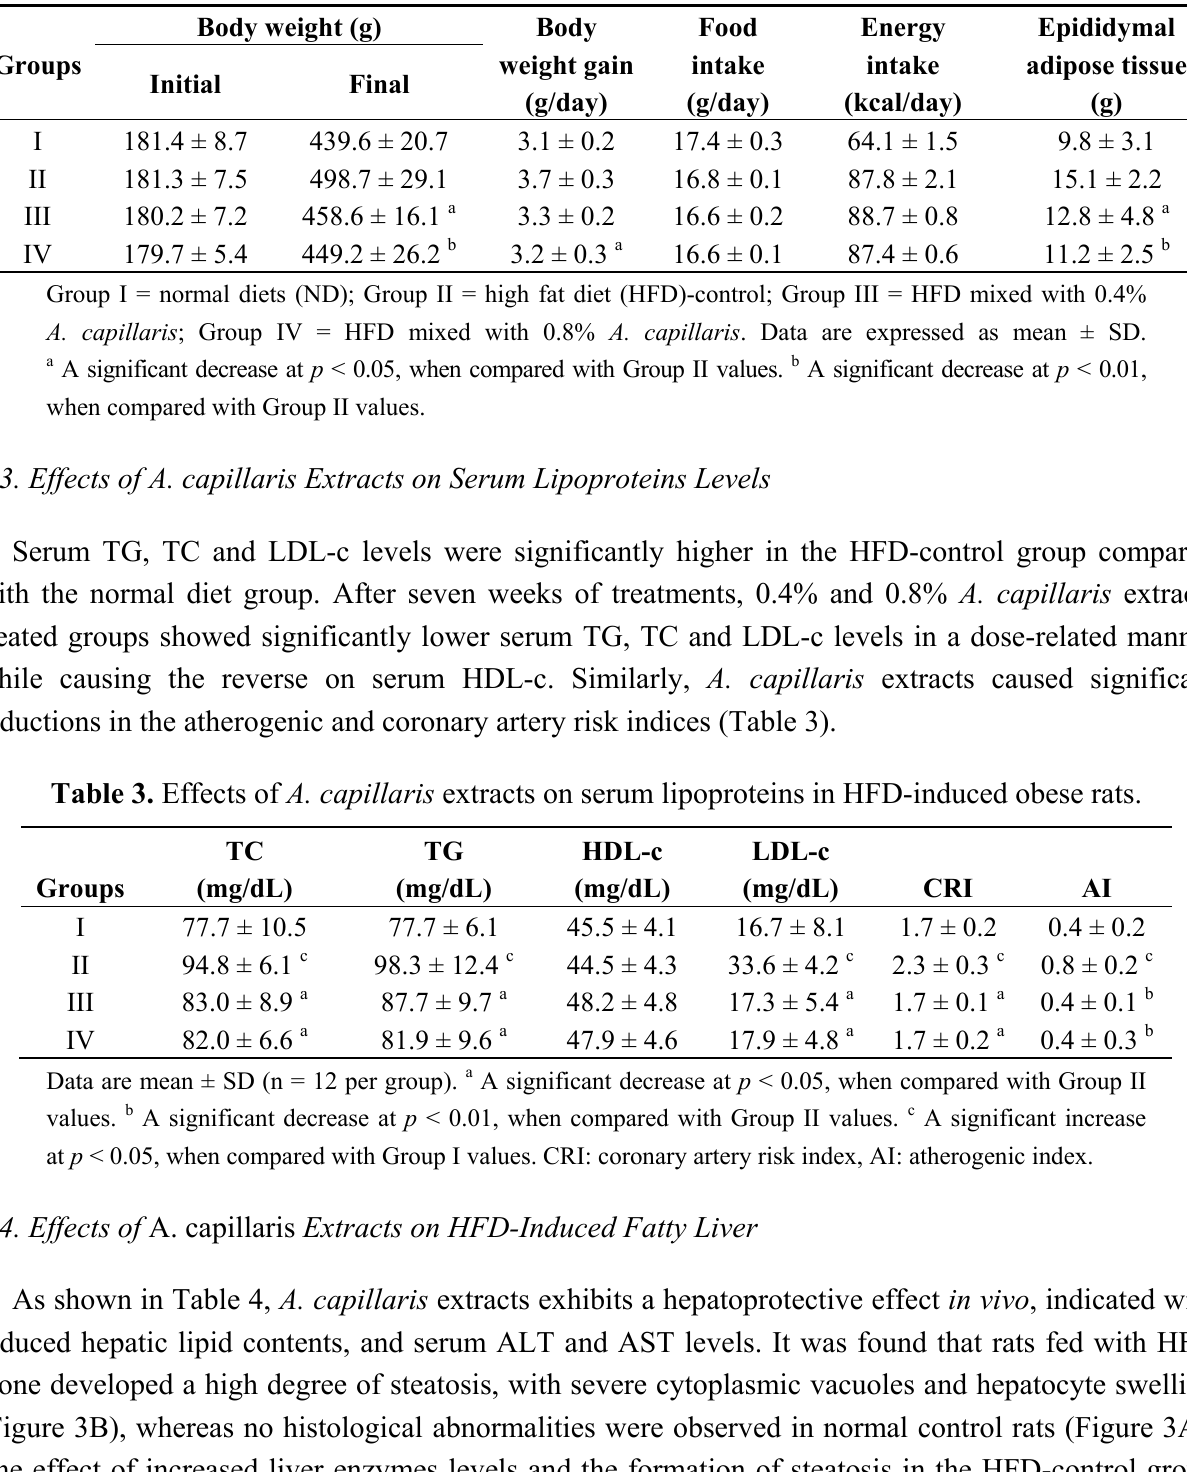
Table 2. Effects of A. capillaris extracts on body weight changes, epididymal adipose tissue weight, and food intake in HFD-induced obese rats.